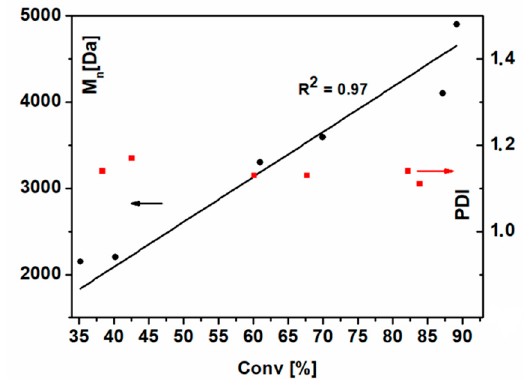
Figure 4. Number-averaged molecular weight and polydispersity indices vs. monomer conversion. Polymerization conditions: [NIPAM]:[NCPAE]:[CuCl]:[Me 6 TREN] = 50:1:1:1, room temperature, isopropanol as a solvent (1:2 NIPAM:solvent, w/w ). The black and red arrows indicate a proper axis for the relationship shown in the same color.